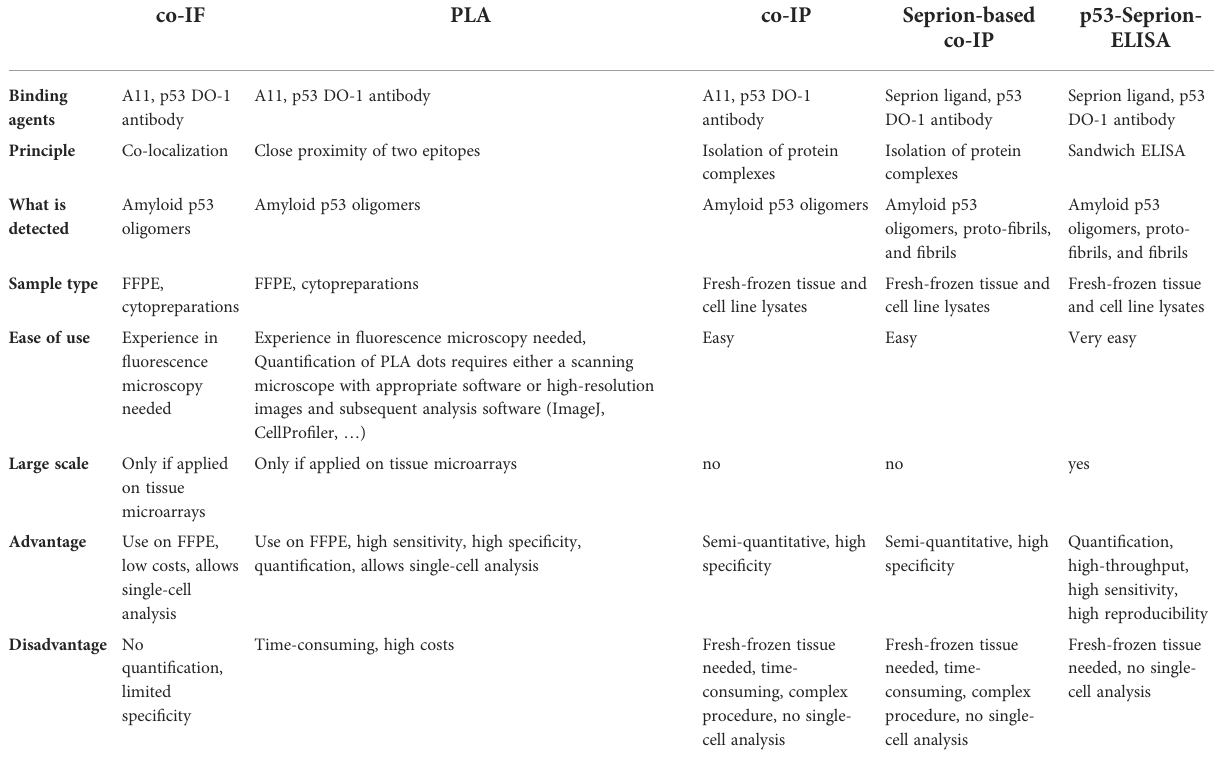
TABLE 2 Overview of methods for the detection of p53 aggregates in cell lines and tissue specimens. co-IF